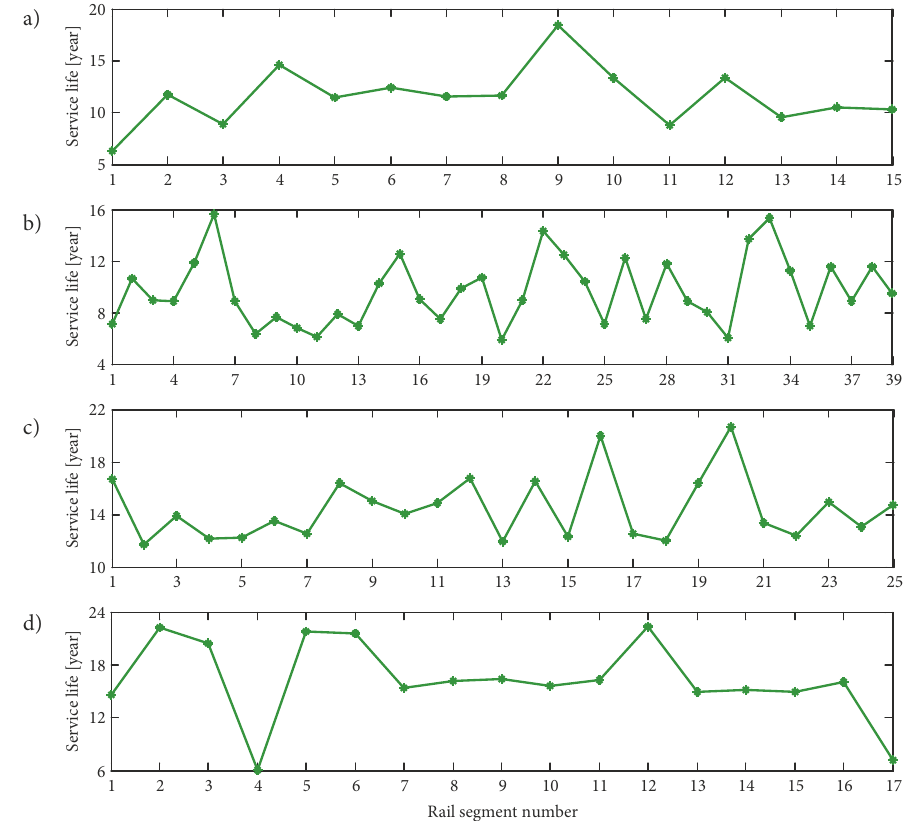
Figure 3. Estimated service lives of rail segments: a – rail segments of Line 1; b – rail segments of Line 2; c – rail segments of Line 10; d – rail segments of Line